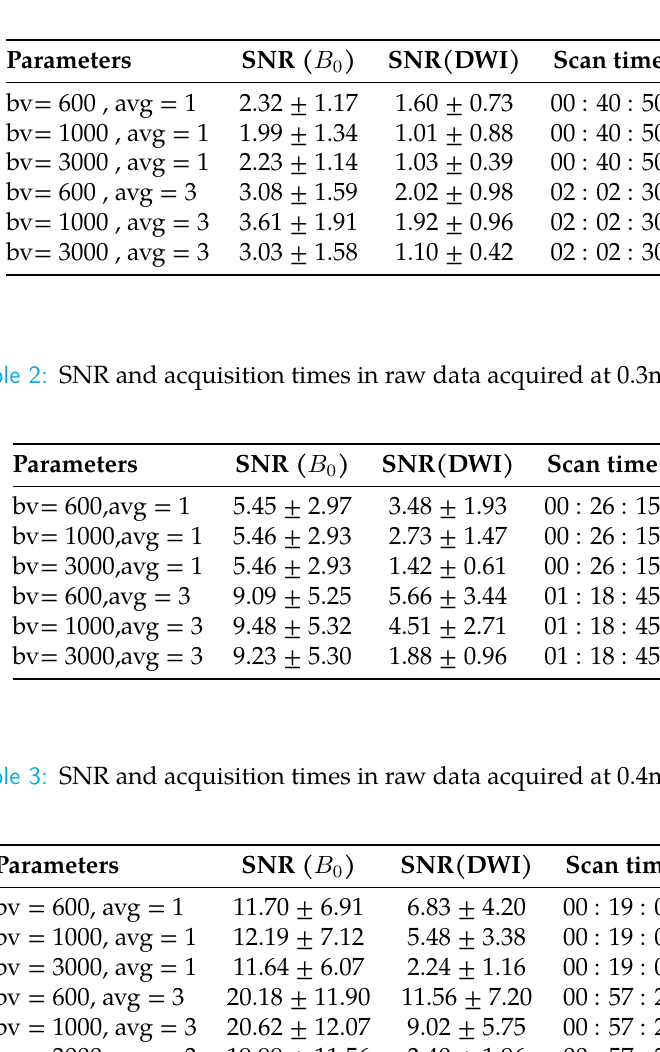
Table 1: SNR and acquisition times in raw data acquired at 0.2mm 3 .